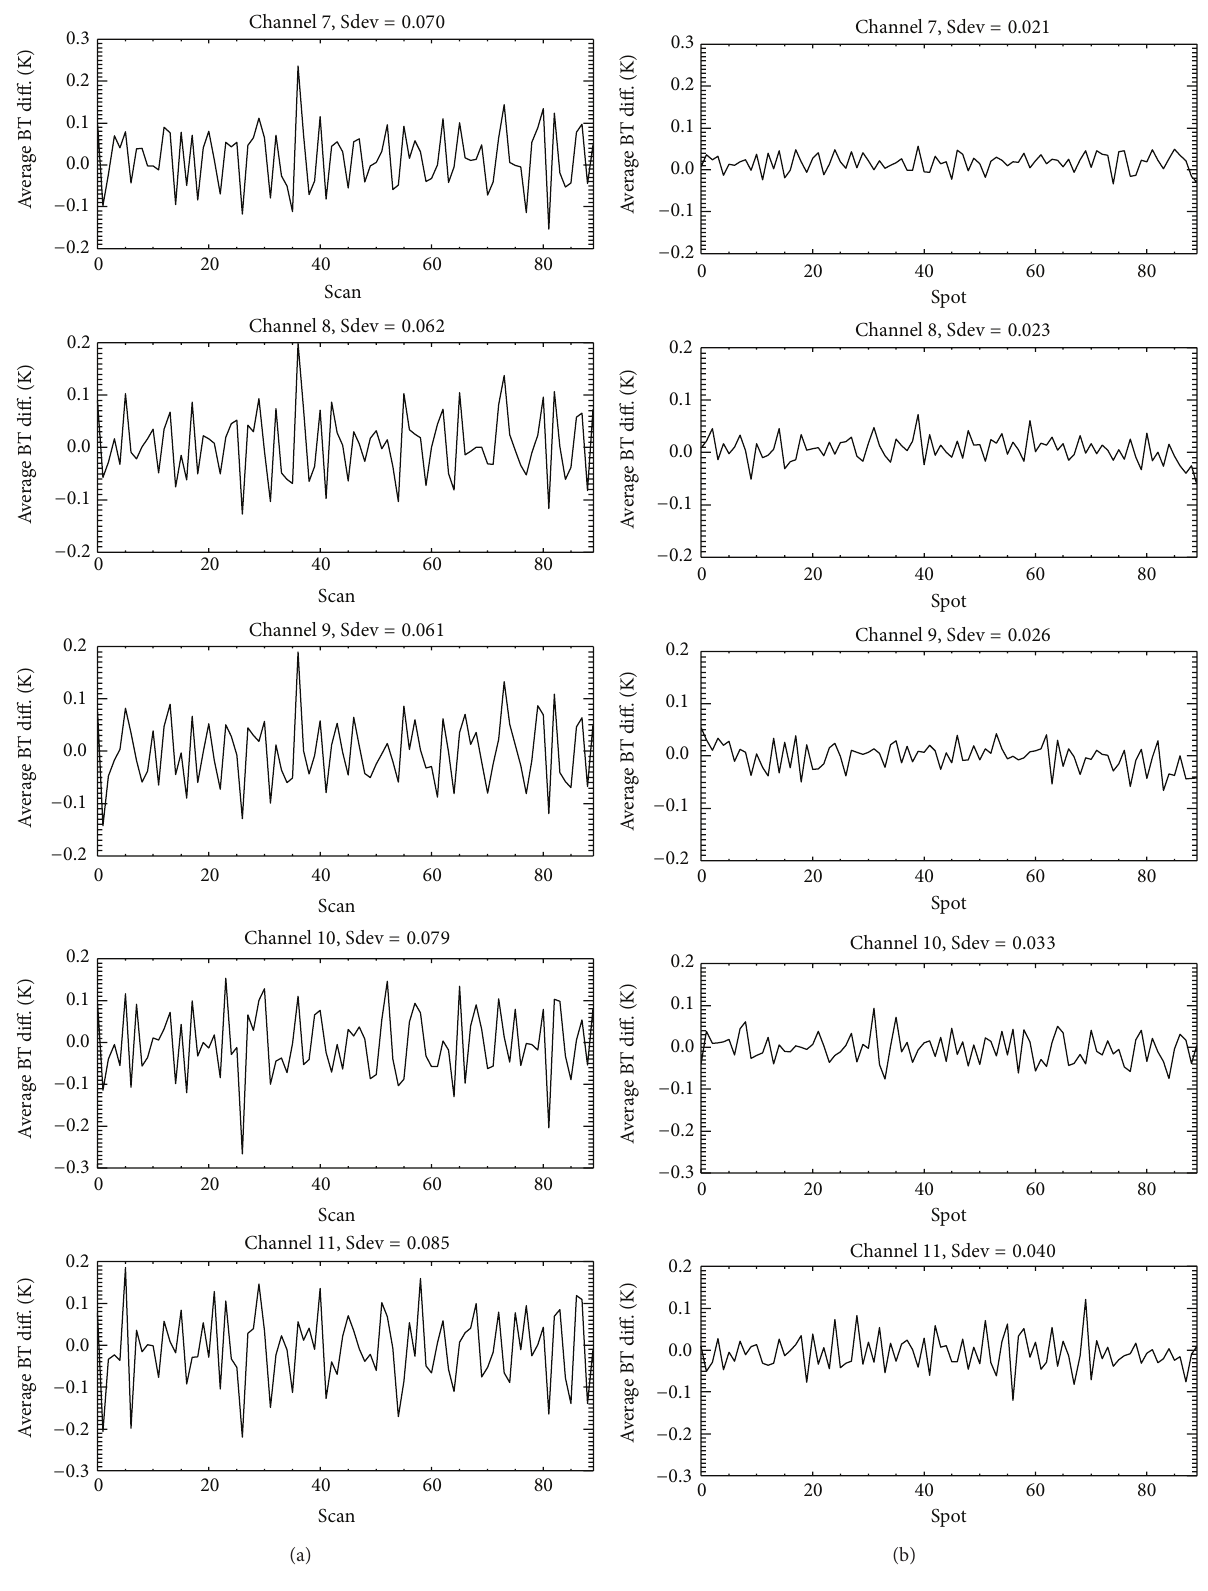
Figure 3: Along-track (a) and cross-track (b) variabilities due to instrument noise for channels